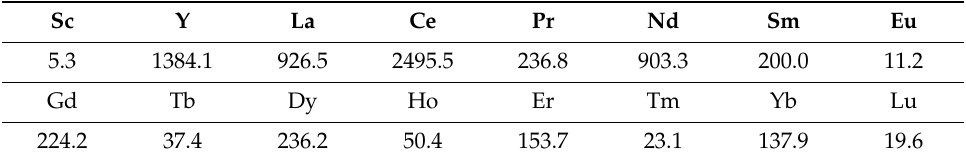
Table 2. Concentrations of rare earth elements in weathered residual rare earth ore, as analyzed by